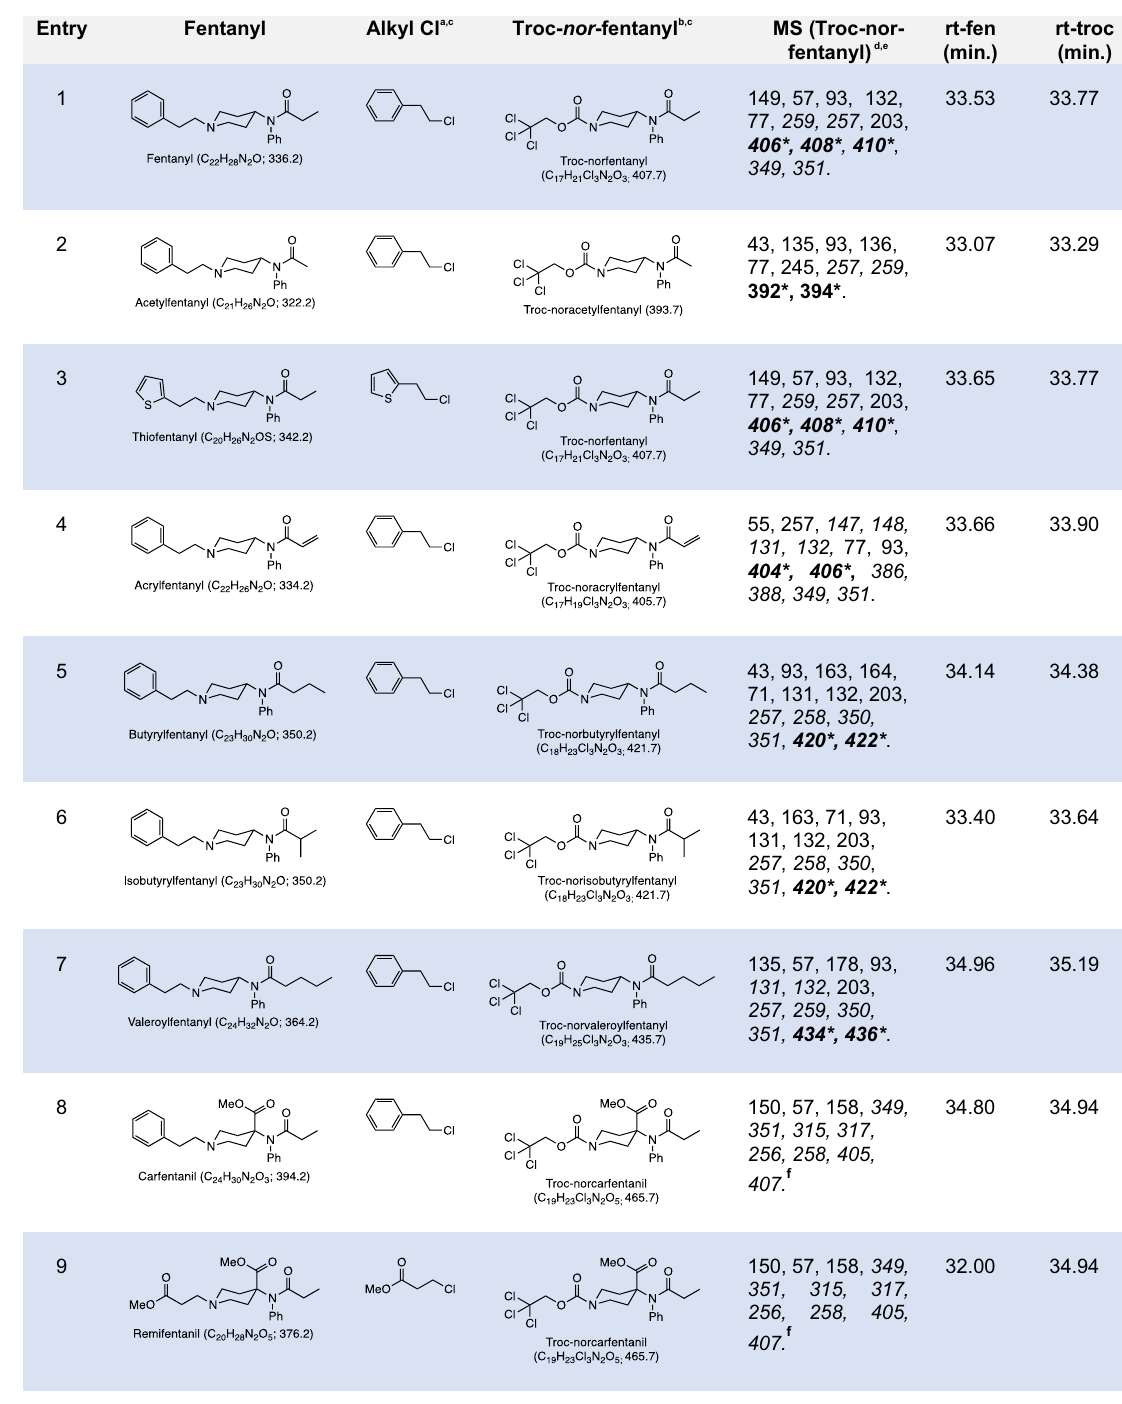
Table 1. a Alkyl chloride from N-alkyl group after reaction; b Troc-norfentanyl fragment after reaction; c Product yields based on GC–MS; d Mass fragments present in the Troc-norfentanyl product after reaction; e Mass fragments in italics belong to chlorine-containing clusters, while italicized and bold-faced fragments bearing an asterisk indicate they are part of the molecular ion peak; f Molecular ion peaks visible upon closer inspection of the spectrum but are in very low